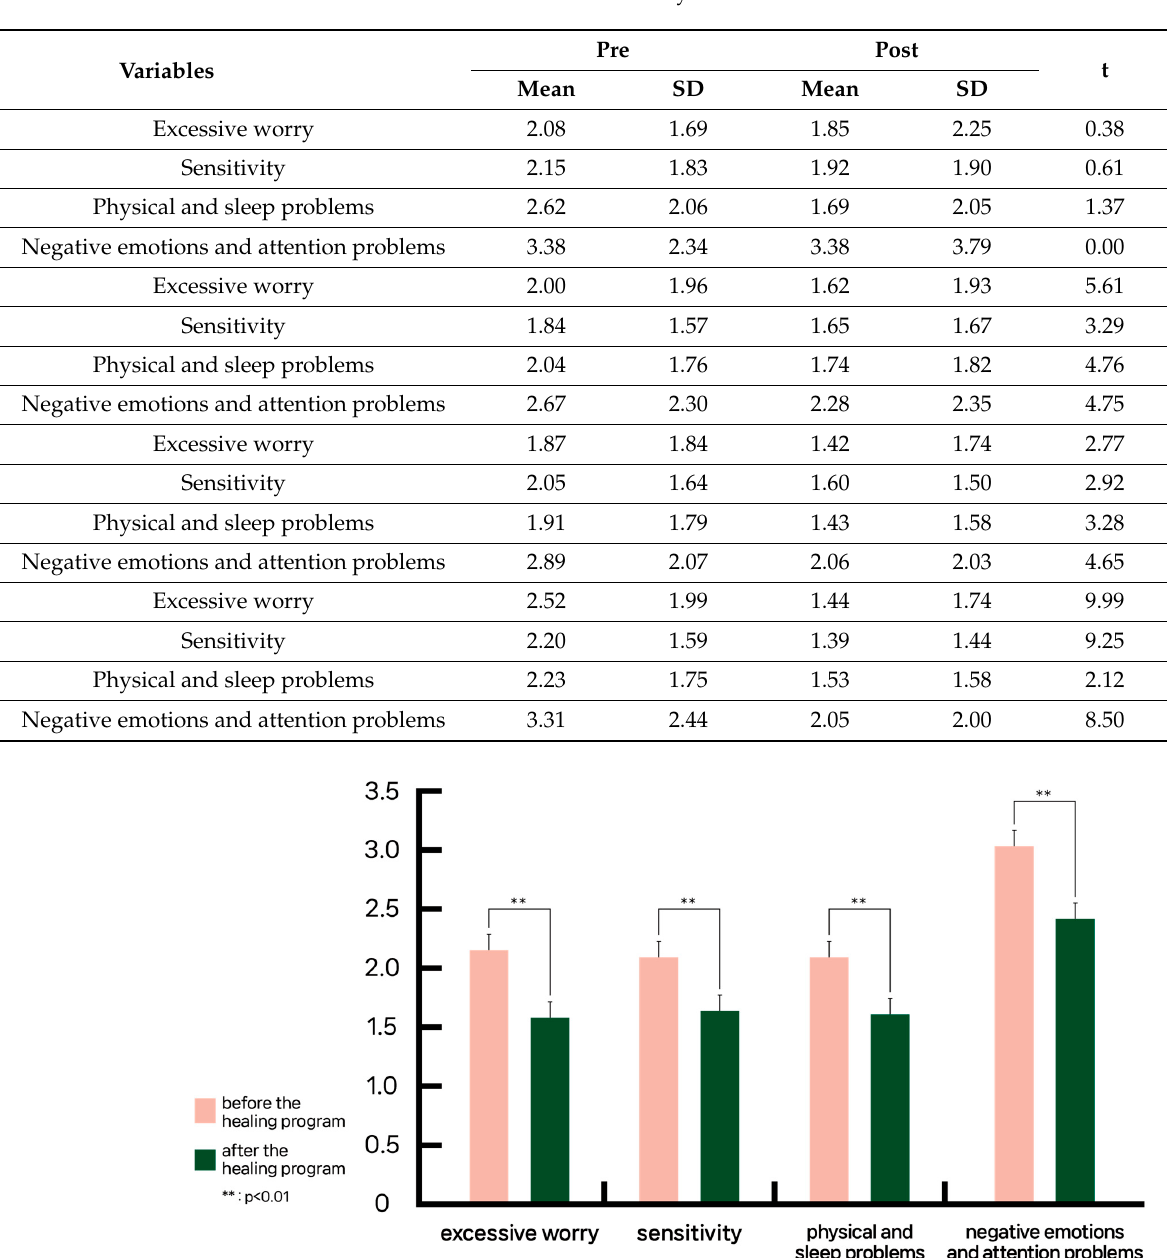
Table 5. Results of RCMAS subdomains for each year 2018–2021.